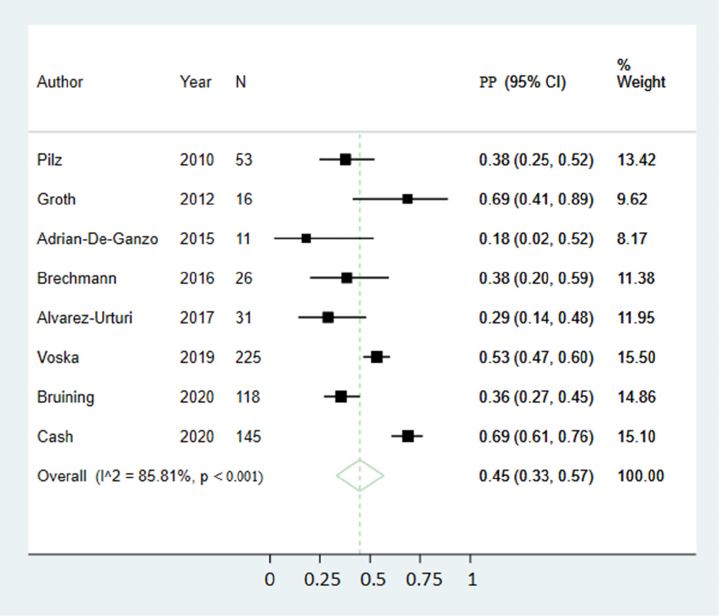
Figure 3. Pooled estimate of colonoscopy preference proportion. Abbreviations: CI, confidence interval; PP, Estimated preference proportion. Diagnostics 2021 , 11 , 1730